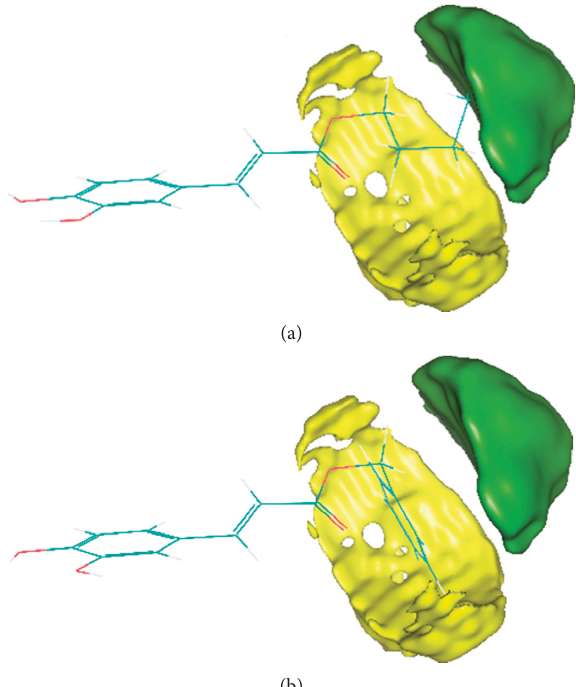
Figure 5: Steric contribution to Staphylococcus aureus bioactivity for compounds 6 and 16